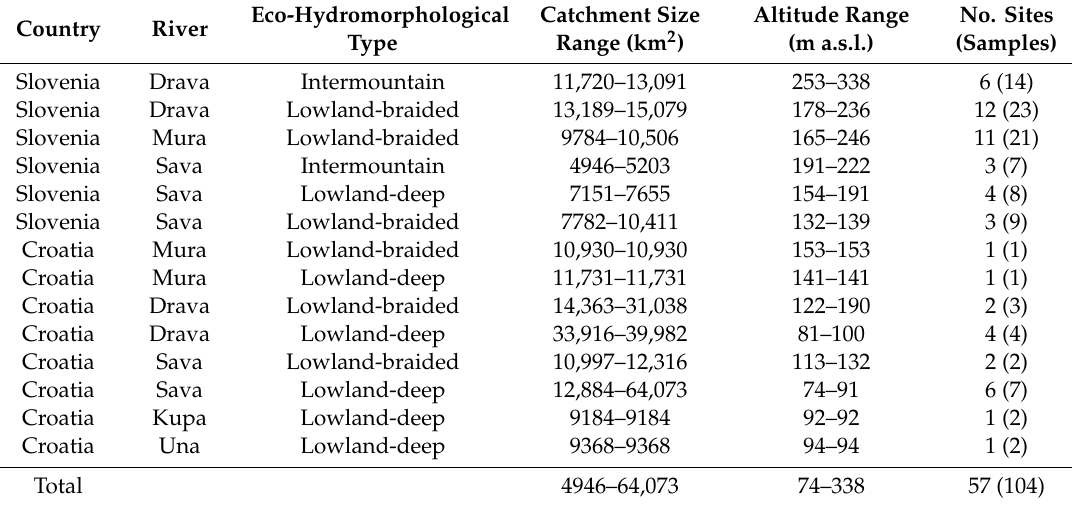
Table 1. Main characteristics of sampled rivers with the number of sampling sites and